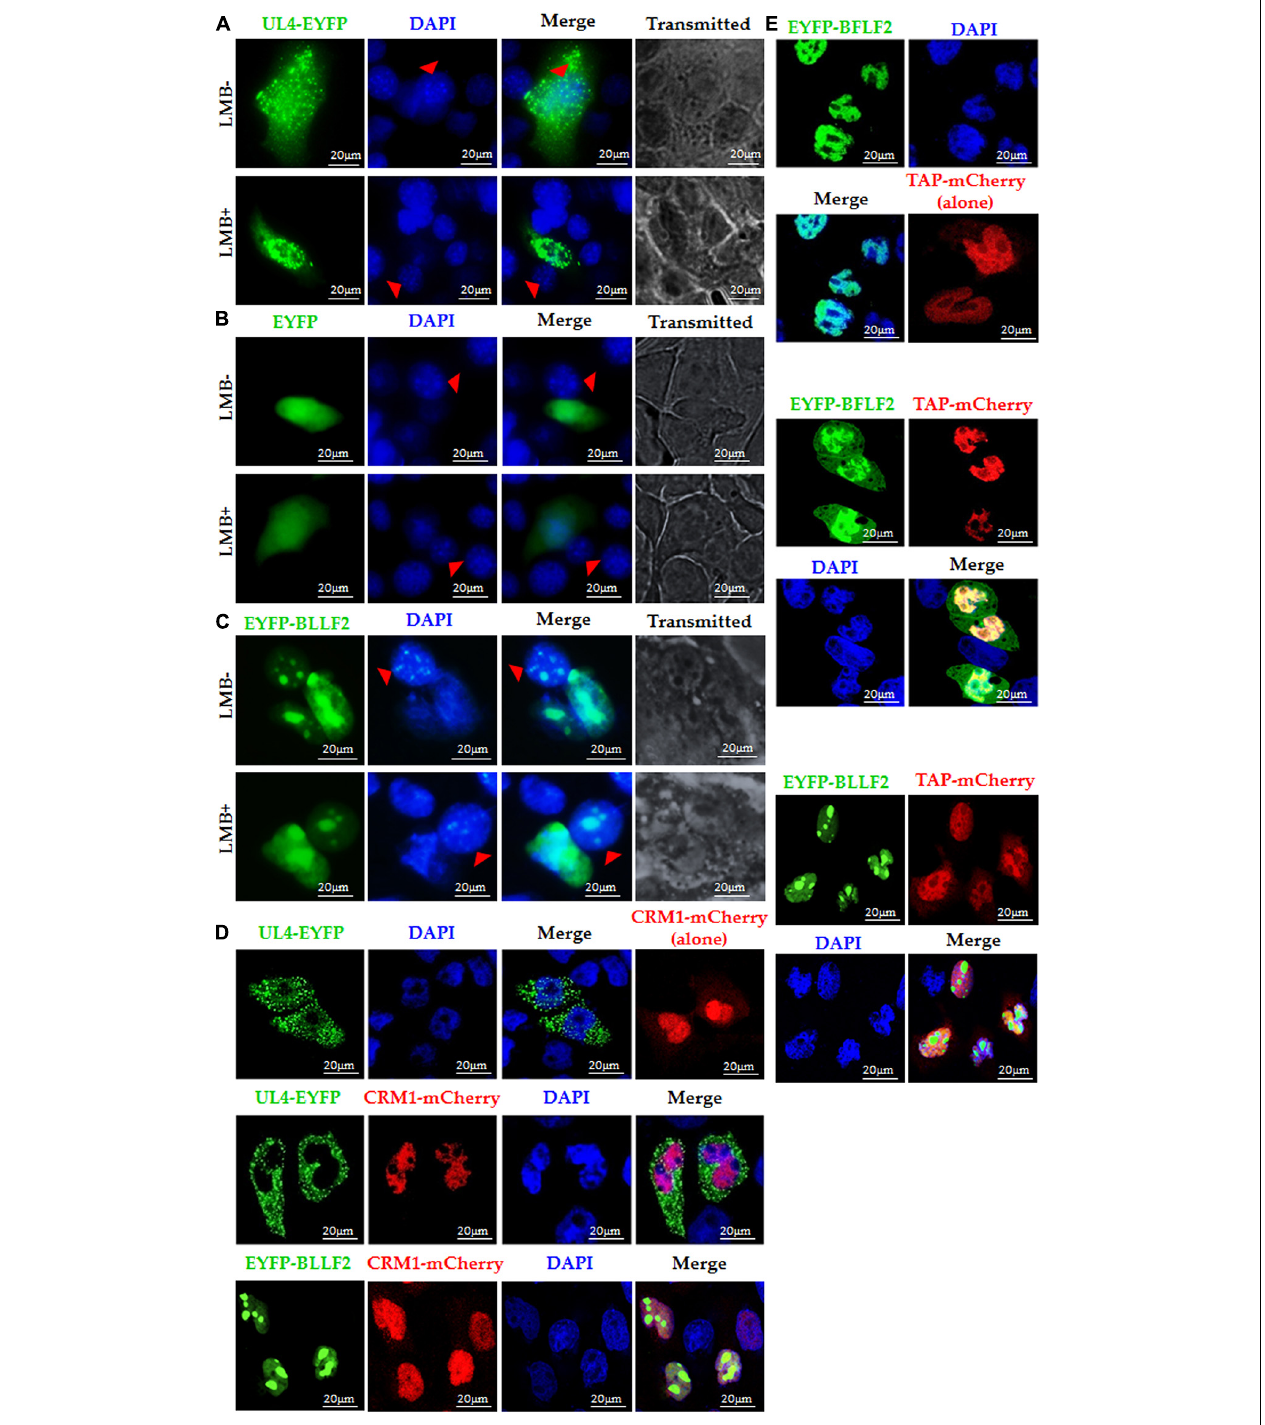
FIGURE 5 | Nuclear export mechanism of BLLF2. Interspecies heterokaryon assays were performed to analyze the nuclear export of BLLF2. Mouse NIH3T3 cells were plated onto the CRM1-dependent positive control UL4 (A) , CRM1-independent negative control EYFP vector (B) , or pEYFP-BLLF2 (C) transfected COS-7 cells, with or without LMB treatment, as described in Section “Materials and Methods.” Cells were then stained with DAPI and imaged by fluorescence microscopy. NIH3T3 cells were identified by their speckled nuclei (red arrowhead). (D) COS-7 cells were individually transfected with UL4-EYFP or co-transfected with expression plasmids CRM1-mCherry/UL4-EYFP or CRM1-mCherry/EYFP-BLLF2 and then examined by confocal microscopy. (E) COS-7 cells were individually transfected with the TAP-dependent positive control EYFP-BFLF2 or co-transfected with expression plasmids TAP-mCherry/EYFP-BFLF2 or TAP-mCherry/EYFP-BLLF2, and then examined by confocal microscopy. All scale bars indicate 20 µ